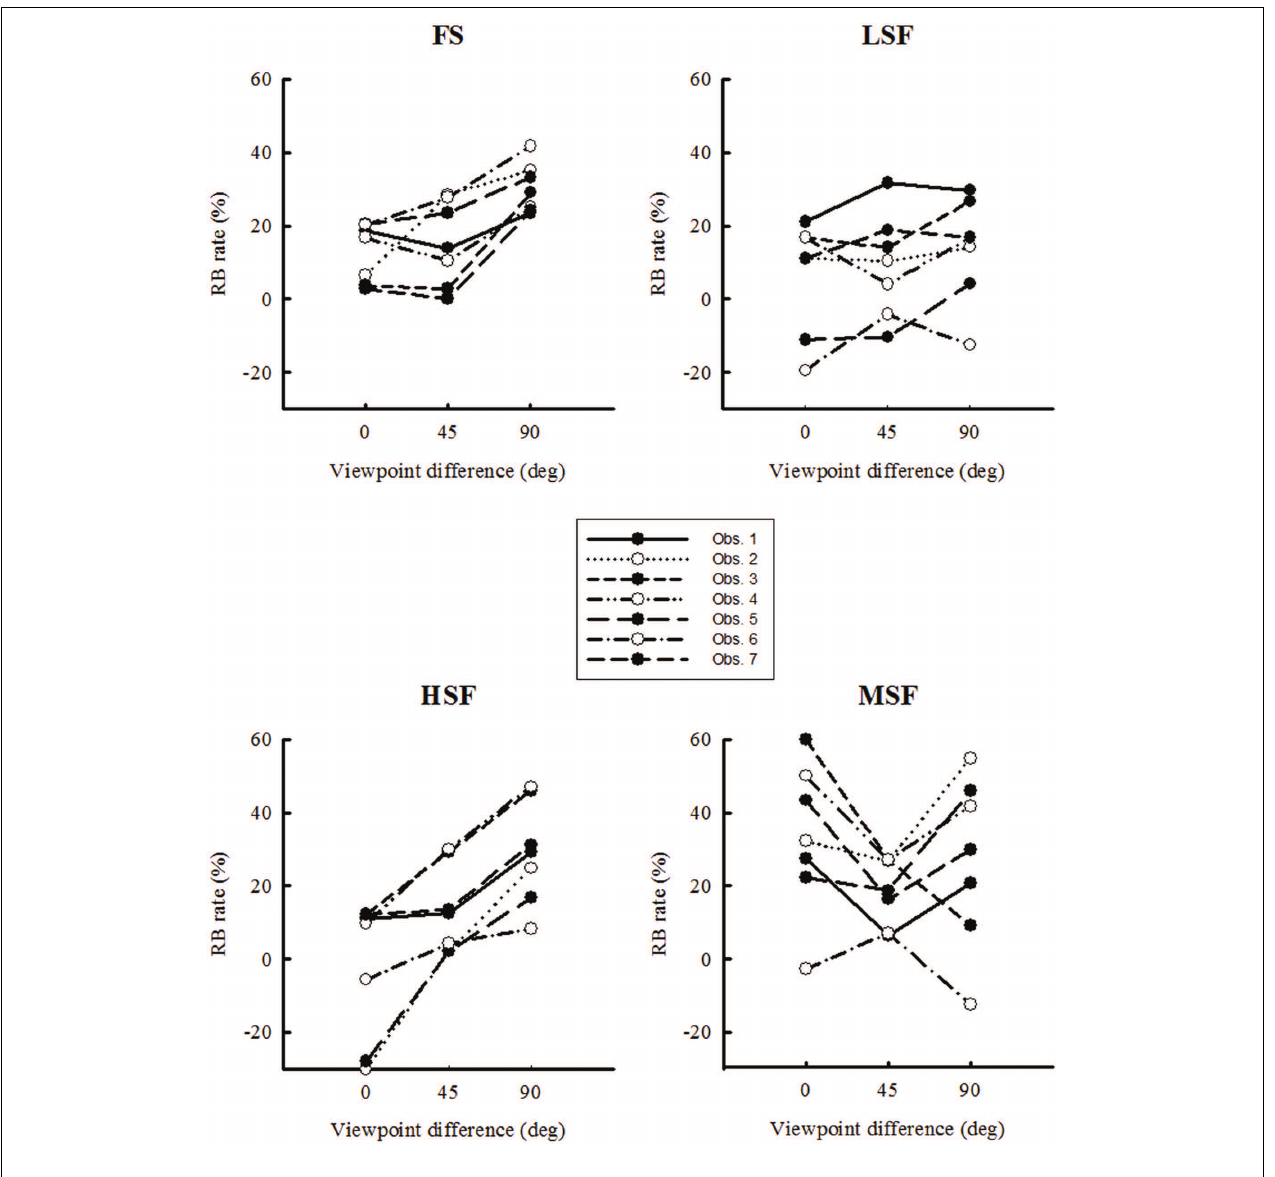
non-repeated condition and the mean correct-response rate in the repeated condition. Error bars are not shown in this figure, to avoid